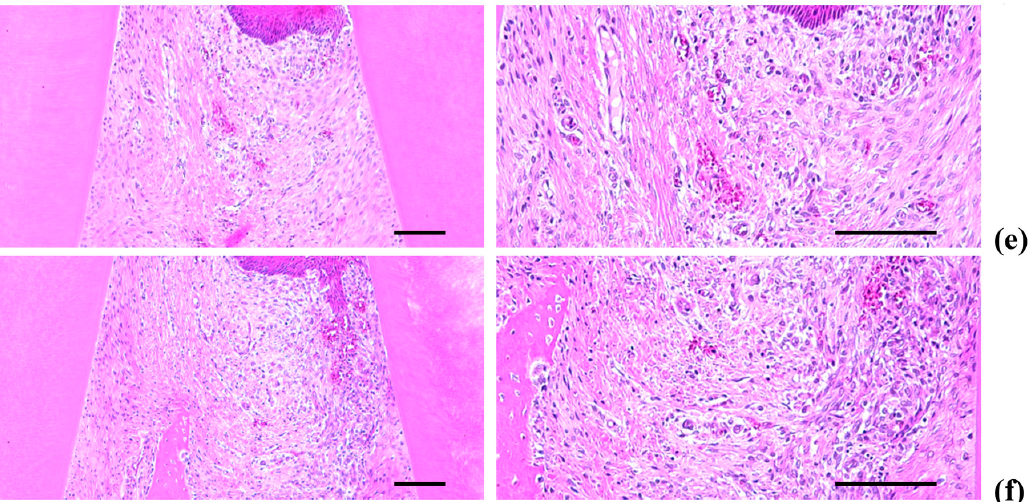
Figure 9. Representative histological images of gingival tissues between upper incisor teeth, taken from Intact or EPD rats around upper left incisor teeth: ( a ) Intact control (Normal control, non-ligated and distilled water topically applied rats); ( b ) EPD control (Ligated EPD induced and distilled water topically applied rats); ( c ) IND (Ligated EPD induced and indomethacin 5 mg/kg orally administered rats); ( d ) Polycal-H (Ligated EPD induced and Polycal 50 mg/mL solution topically applied rats); ( e ) Polycal-M (Ligated EPD induced and Polycal 25 mg/mL solution topically applied rats); and ( f ) Polycal-L (Ligated EPD induced and Polycal 12.5 mg/mL solution topically applied rats). All H & E stain. Scale bars = 120 μ m.